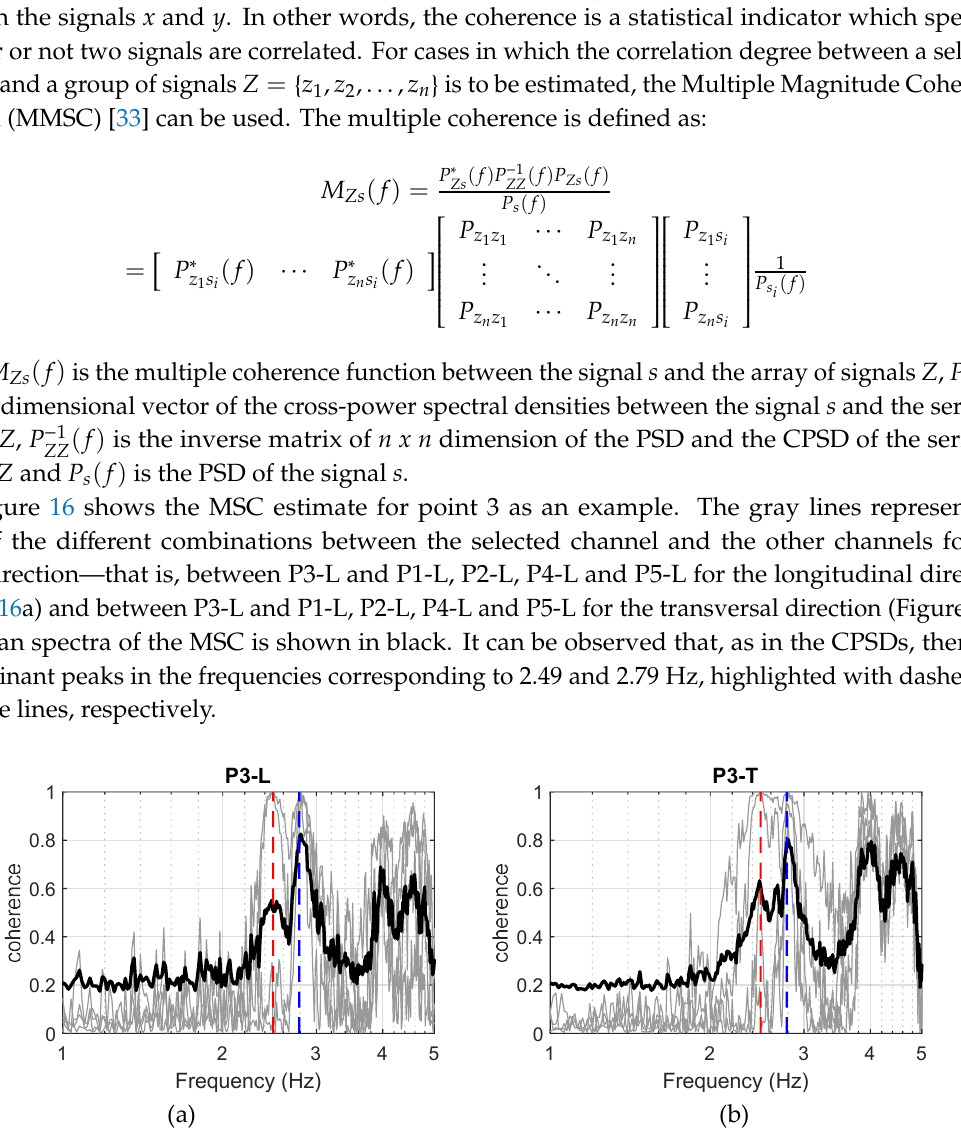
Figure 16. The MSCs (grey lines) of the combination between the longitudinal ( a ) and transversal ( b ) signals in point P3 and the rest of the signals in the same directions. The black lines correspond to the mean MSC and the frequencies 2.49 and 2.79 Hz are indicated with red and blue dashed lines, respectively.